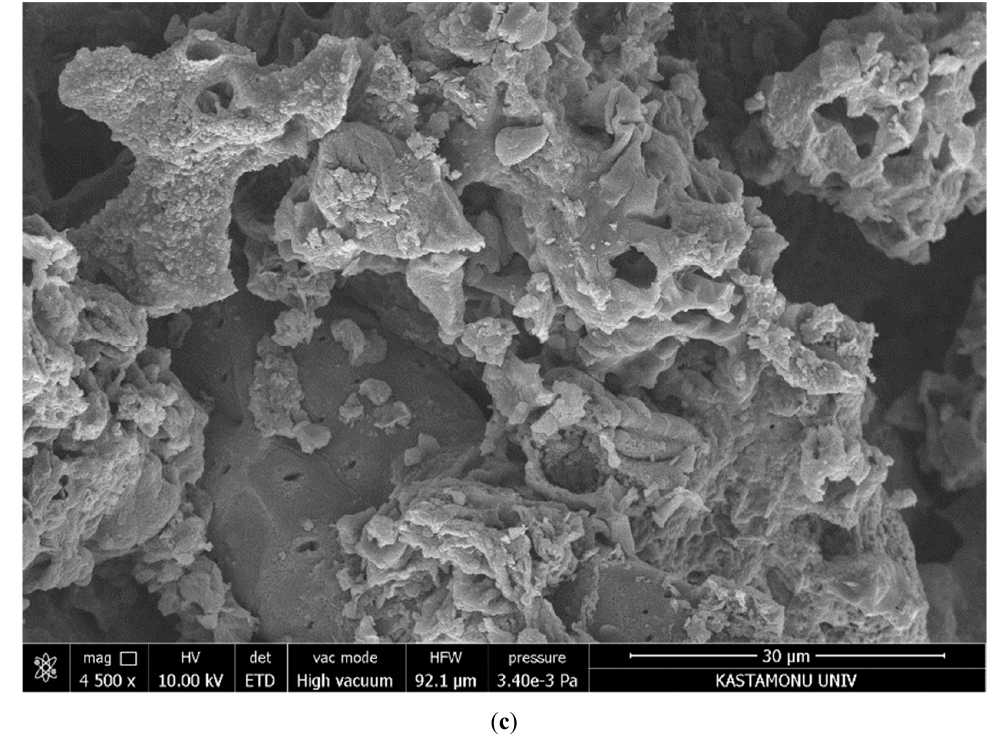
Figure 2. Representation of SEM images of ( a ): PASB, ( b ): PASAC23 and ( c ): PASAC35.